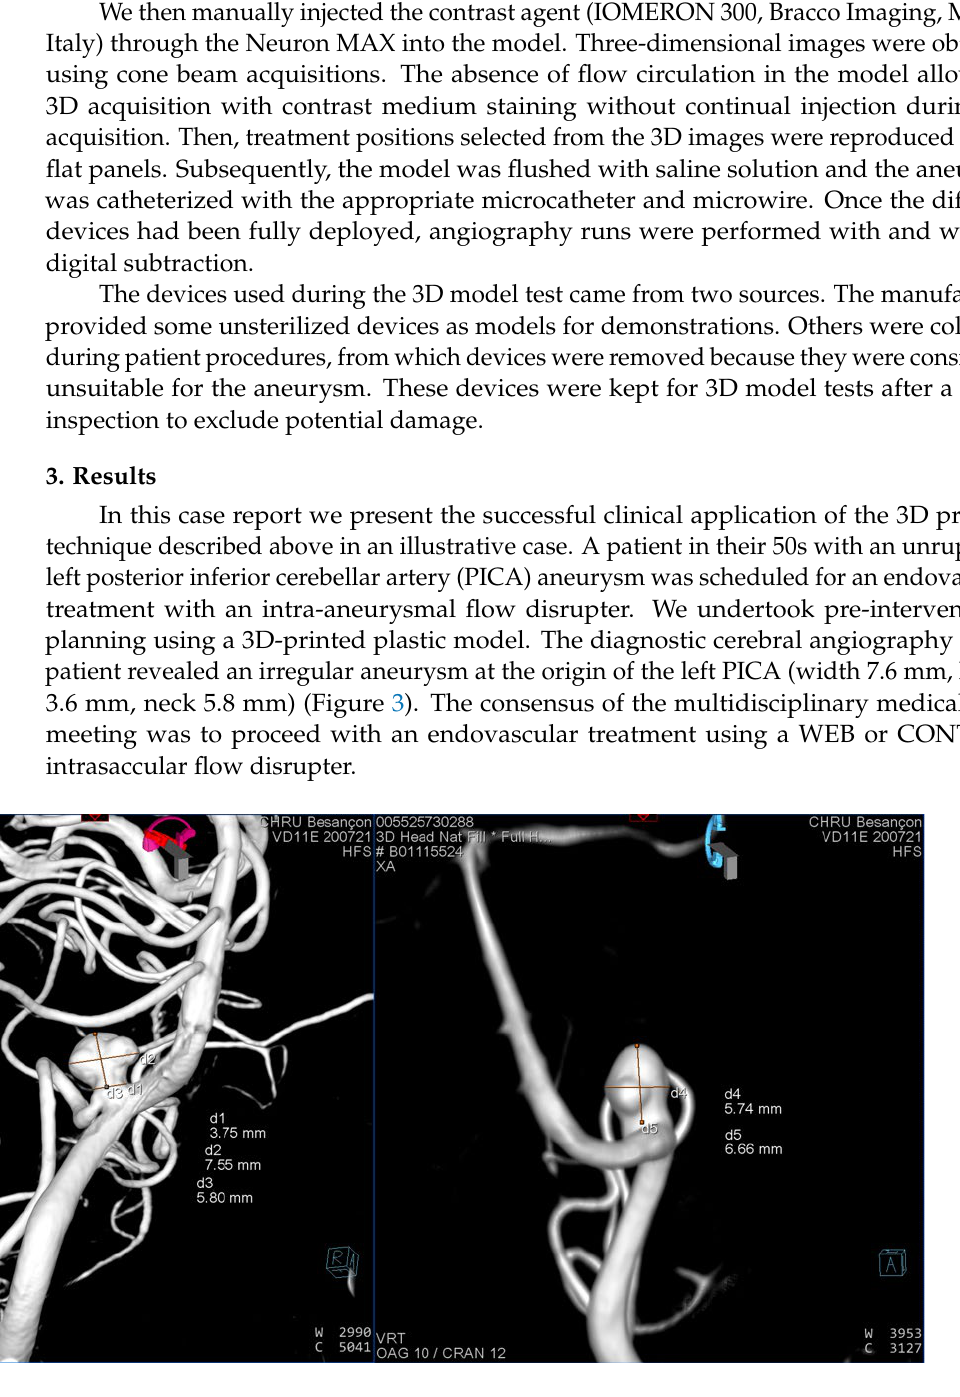
Figure 3. 3D rotational angiography reconstruction of the left vertebral artery 3 months before the intervention.